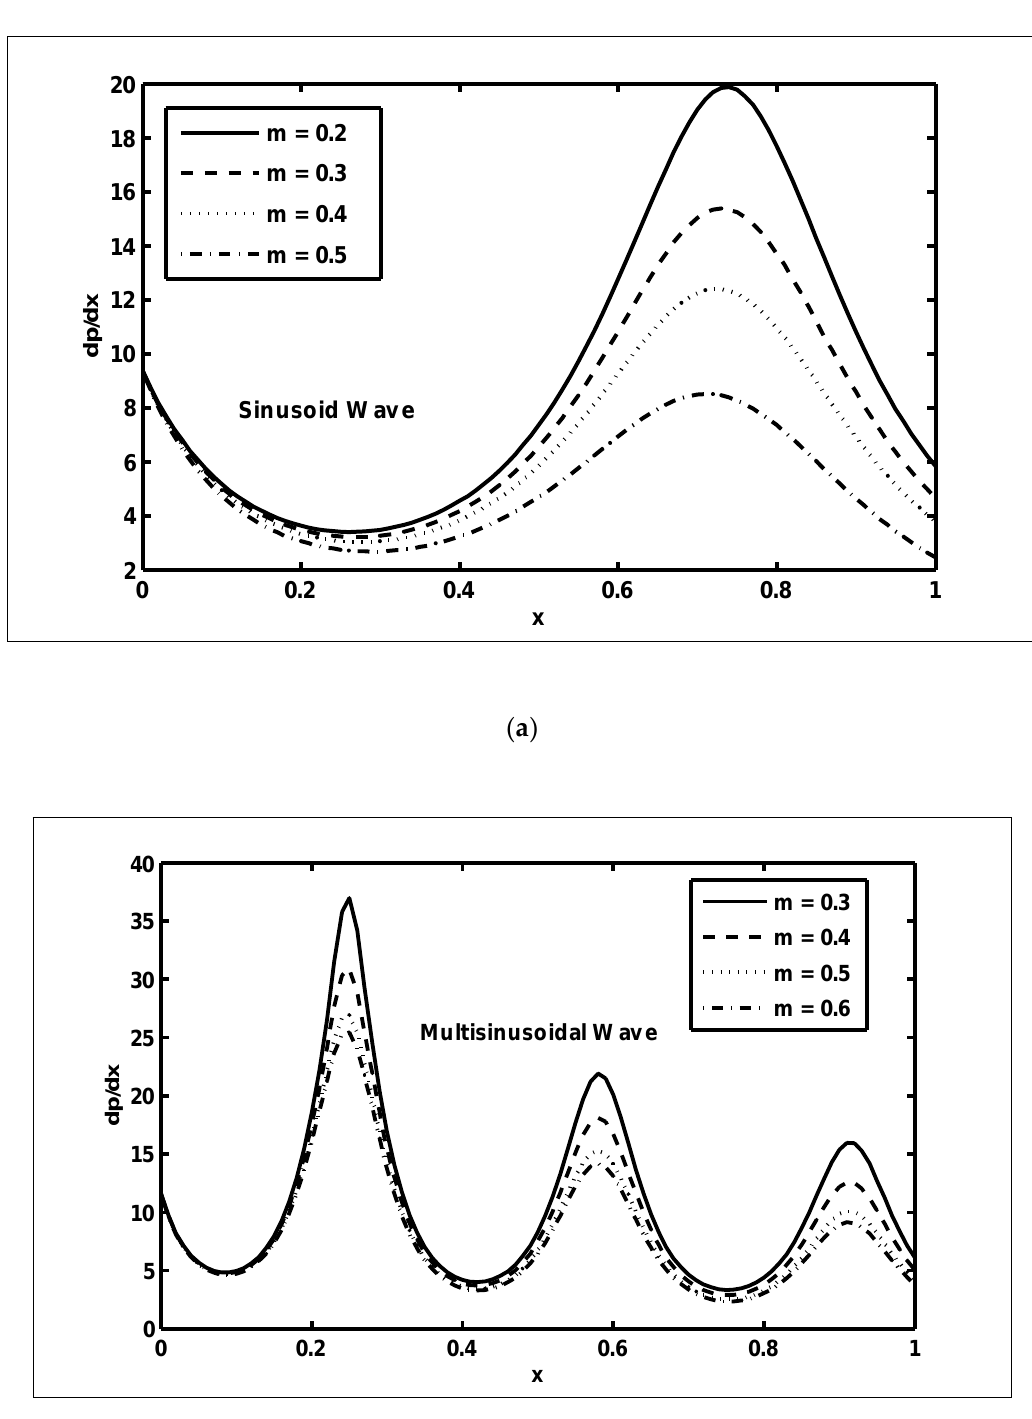
Figure 3. The pressure gradient ( 𝑑𝑝/𝑑𝑥 ) against the axial distance ( 𝑥 ): ( a ) 𝑁 𝐶𝑇 = 0.3, 𝑁 𝑇𝐶 = 0.7, 𝐺 = 0.4, 𝐺 = 0.1, 𝐺 = 0.5, 𝑁 = 0.7, 𝑀 = 4, 𝜙 = 𝜋 𝑟𝑐 𝑟𝐹 𝑟𝑡 𝑡 ( b ) 𝑁 𝐶𝑇 = 0.3, 𝑁 𝑇𝐶 = 0.7, 𝐺 𝑟𝑐 = 0.4, 𝑁 𝑏 = 0.1, 𝐺 𝑟𝑡 = 0.5, 𝑁 𝑡 = 0.7, 𝑀 = 4, 𝜙 = 𝑚 = 0.4, 𝑄 = −5.